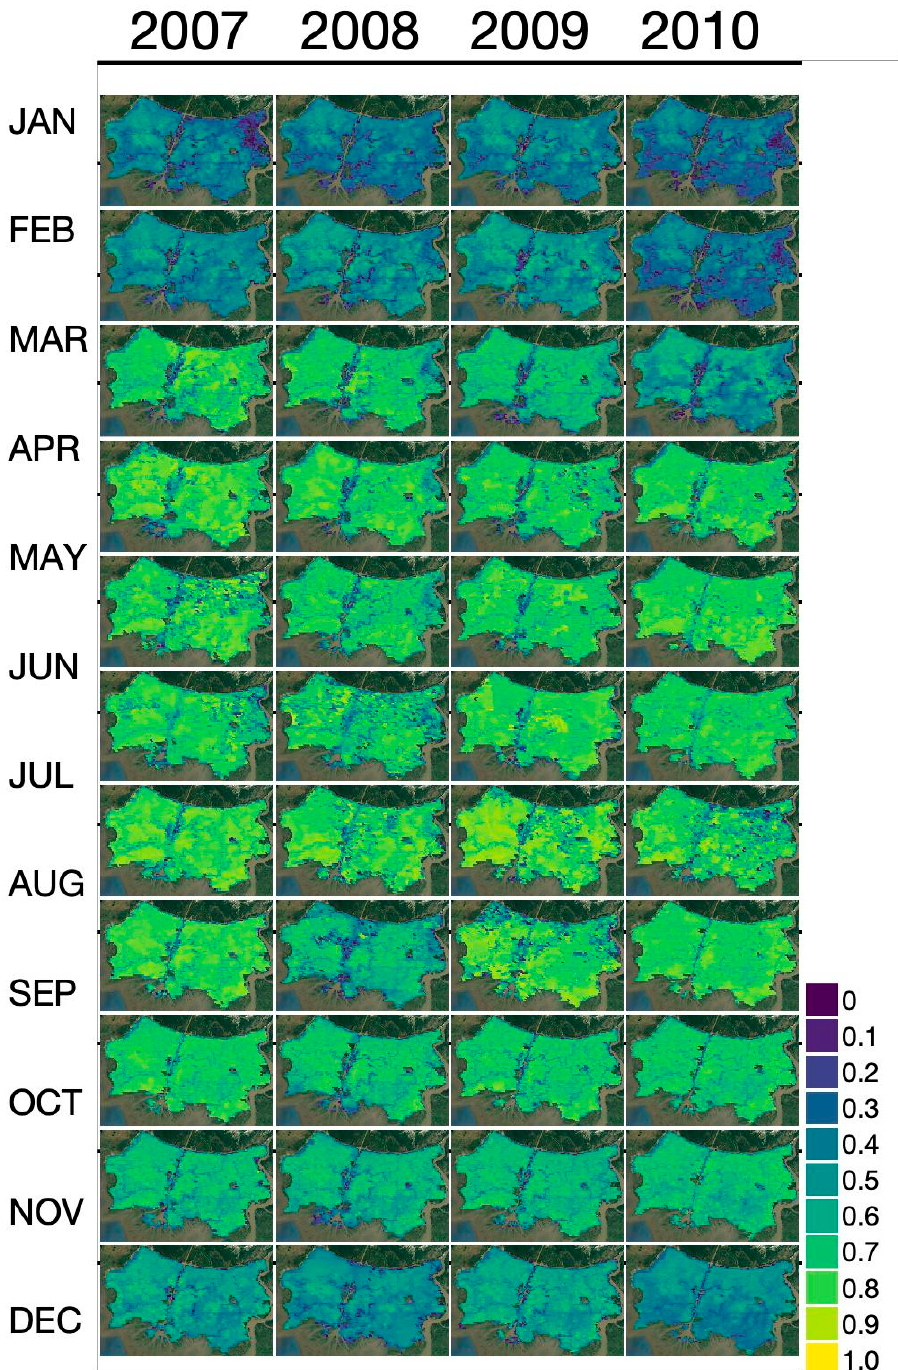
Figure 5. The calendar of NDVI maps from MODIS during 2007 and 2010. (Background Map from Google [26]).